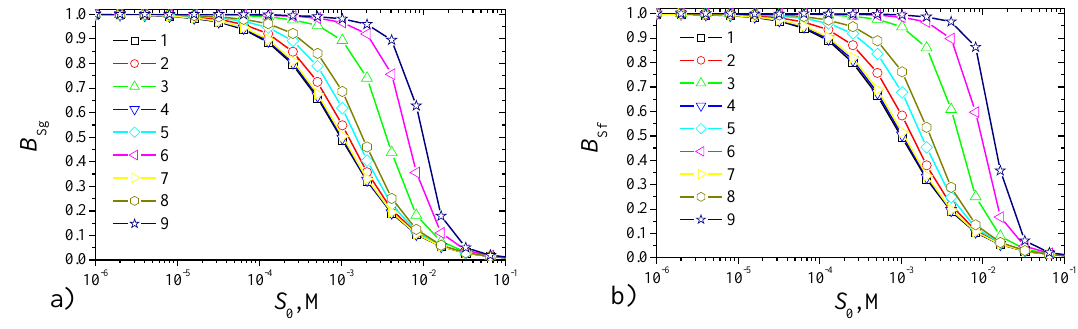
in the cases of 0 at 0